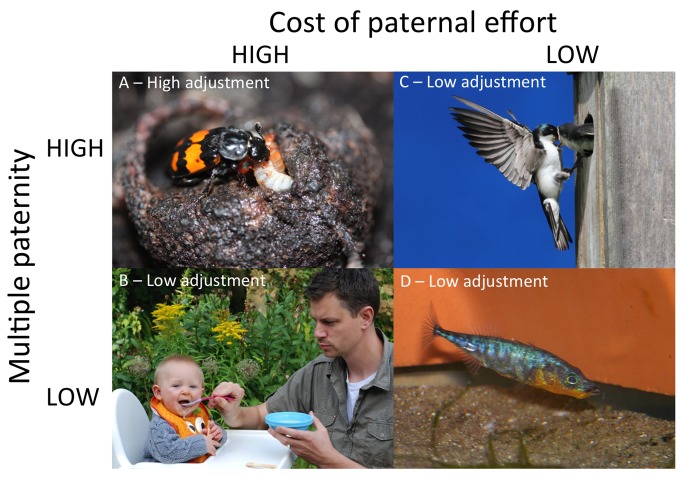
Four case studies of paternal care adjustment in response to female promiscuity.(A) Males of the burying beetle genus Nicrophorus, are unique among insects in the level of paternal care provided, and this care is costly: males reduce future reproductive success by caring for offspring in a current brood. Males also have a relatively high chance of being cuckolded. These two factors drive selection for male burying beetles to spend less time with their brood if they have been cuckolded. (B) Like burying beetles, male humans, Homo sapiens, reduce their chance of breeding successfully in future by providing paternal care, but relatively low risk of cuckoldry reduces selection for adjustment. (C) Paternal care can be extremely demanding in nesting birds, but in the case of the tree swallow, this energetic cost has relatively weak effect on the chance that males will breed successfully in future. Consequently, adjustment is relatively weak, despite the fact that females are relatively promiscuous. (D) This male three-spined stickleback, Gasterosteus aculeatus, cares for his eggs by defending them from predators and keeping them well-oxygenated by fanning, but he may also start to eat them if he is hungry. Compared to burying beetles, however, paternity has less influence on a male's care decisions because female promiscuity and the cost of caring are both relatively low in this species. Photos courtesy of P. Smiseth (burying beetle), E. Cornwallis (humans), S. Byland (tree swallow), and M. Head (three-spined stickleback).